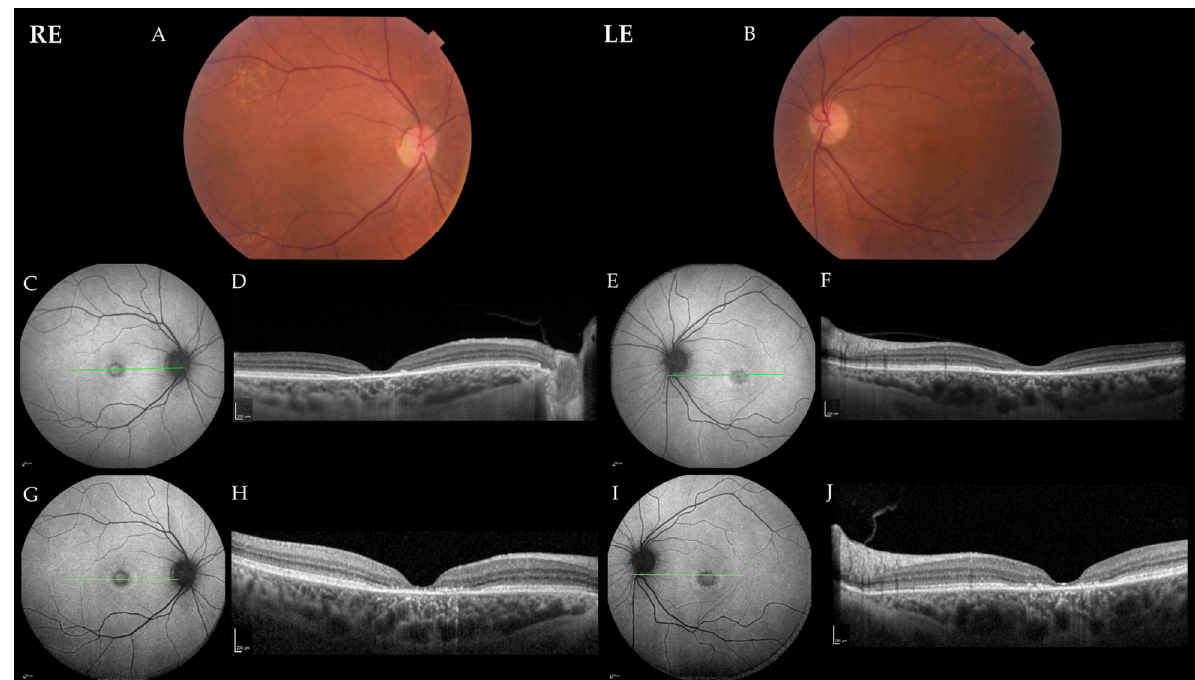
Figure 4. Color fundus photos and progression of DRAM2 retinopathy in Patient 2. ( A , B ) Color fundus photos at the age of 63 years; ( C , E ) fundus autofluorescence (FAF) and ( D , F ) optical coherence tomography (OCT) images at the age of 61 years; ( G , H ) fundus autofluorescence and ( I , J ) and OCT images at the age of 63 years. Green lines in the FAF images show the location of the corresponding OCT scans. Note a minimal darkening of the foveal hypoautofluorescence corresponding to the increased signal passing through the choroid on the OCT, reflecting retinal pigment epithelium atrophy. Abbreviations: RE—right eye; LE—left eye.